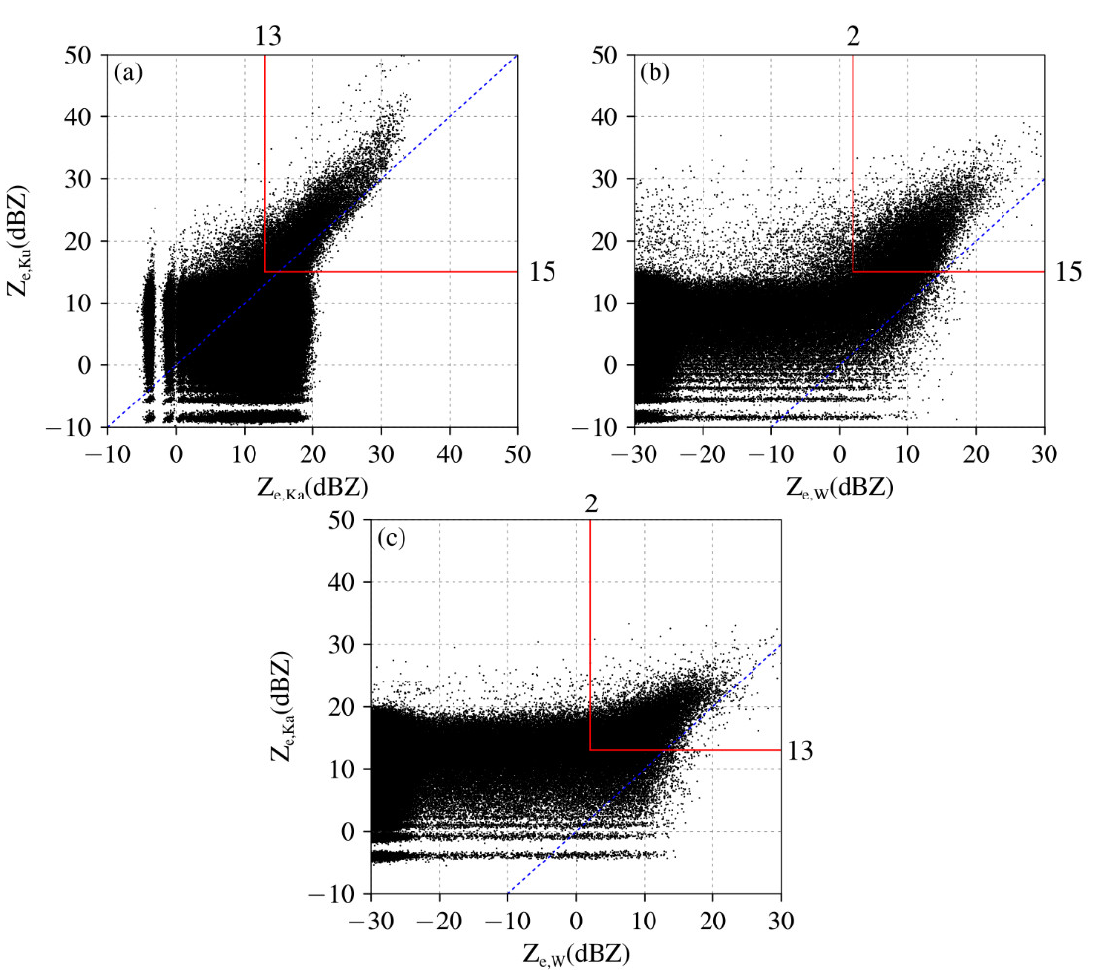
Figure 1. Scatterplots of radar reflectivities between ( a ) Ku and Ka, ( b ) Ku and W and ( c ) Ka and W bands.